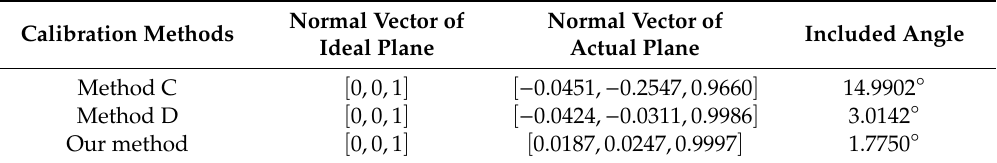
Table 4. Normal vectors of plane obtained by the three calibration methods.